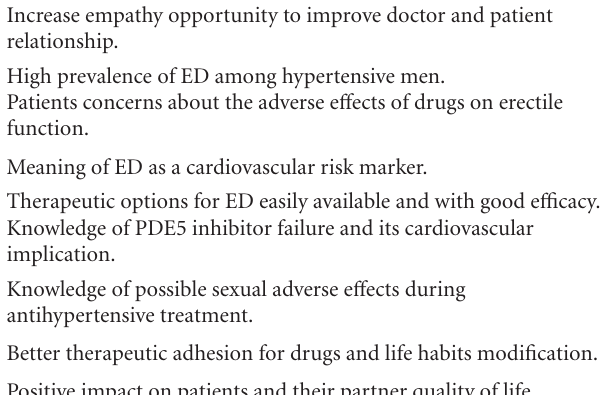
Table 2: Reasons to ask about your patient’s sexual life during your next